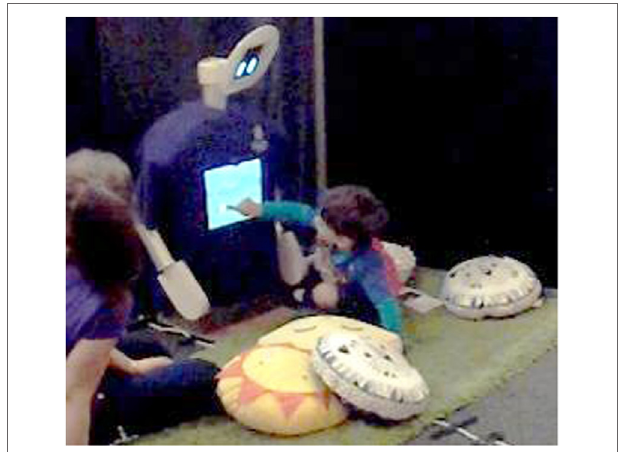
FigUre 4 | A typical interaction between Opie and a child. The child presses Opie’s torso tablet within the interactive story.